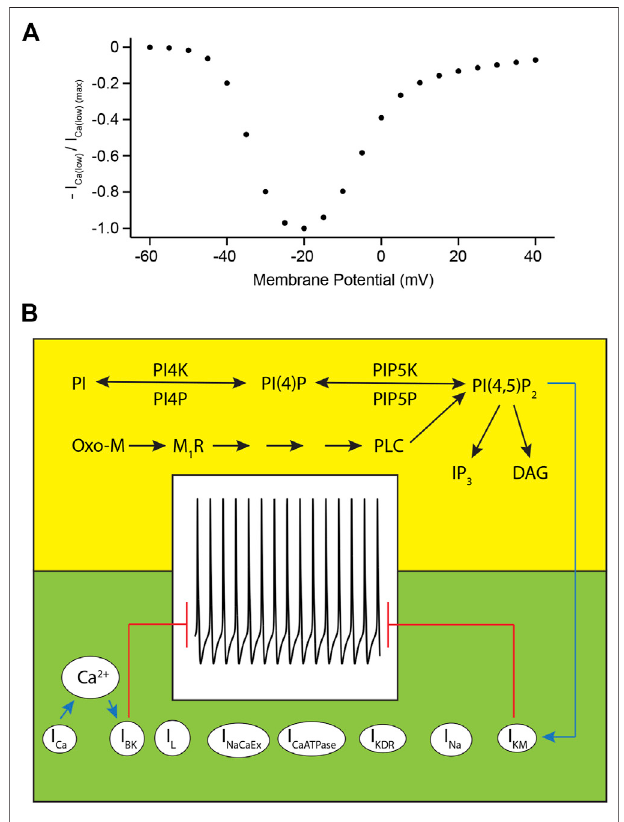
FIGURE 9 | Voltage-dependence of low-threshold L-type calcium channels and model characteristics. (A) . Normalized simulated current amplitude of low-threshold L-type calcium channels plotted against membranepotential. (B) .Illustrationofregulationofactionpotential fi ring ofratSCGneuronsbyphosphoinositidemetabolism (yellowbackground)and ion channel activity (green background). Blue arrows indicate activation of KCNQ2/3 channels by PI(4,5)P 2 or of KCNMA1 channels by Ca 2+ ions entering the cell through L-typecalcium channels. Red lines indicate that non- inhibited activity of KCNQ2/3 and KCNMA1 channels prevents action potential fi